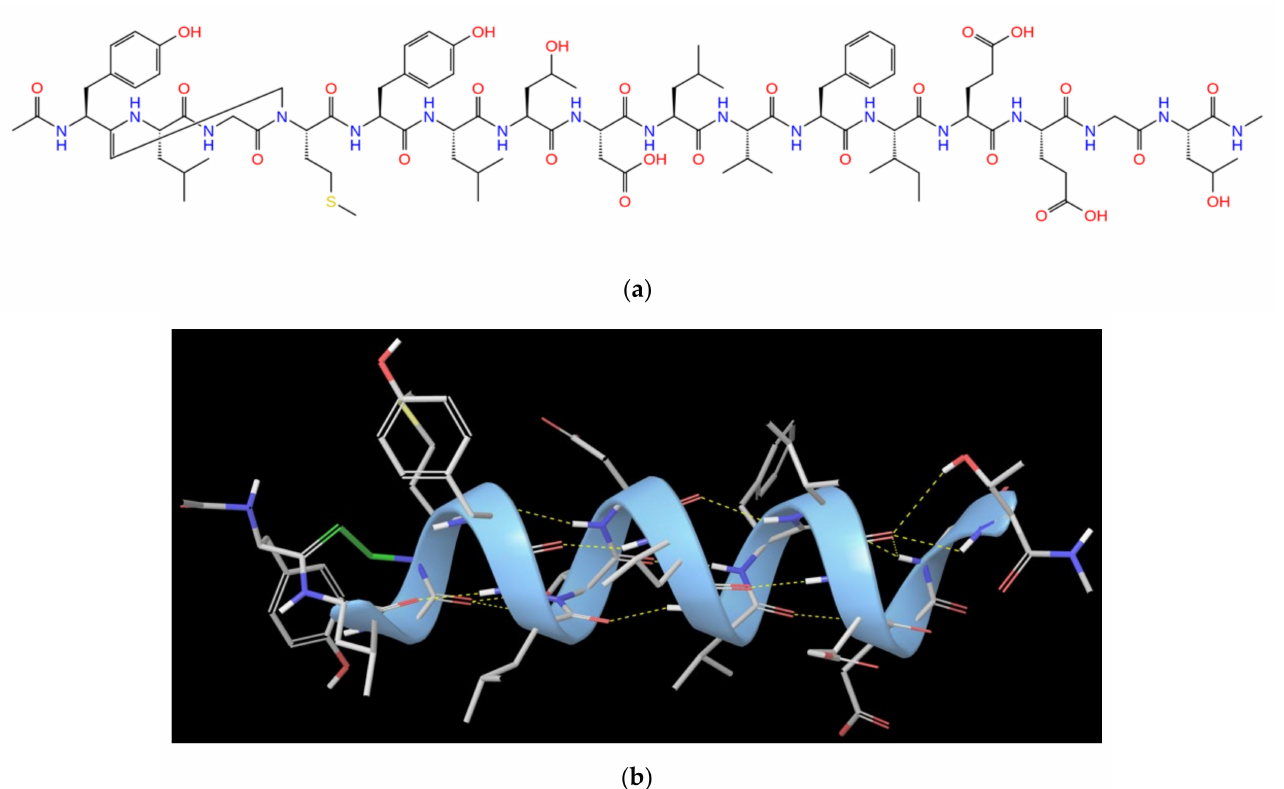
Figure 6. ( a ) Structure of the 3 10 -HBS RB3 peptide; ( b ) the 3 10 -HBS RB3 peptide including a covalent C-C bond (green bond) between the carbonyl oxygen of Tyr1178 backbone and the amine hydrogen of Met1181